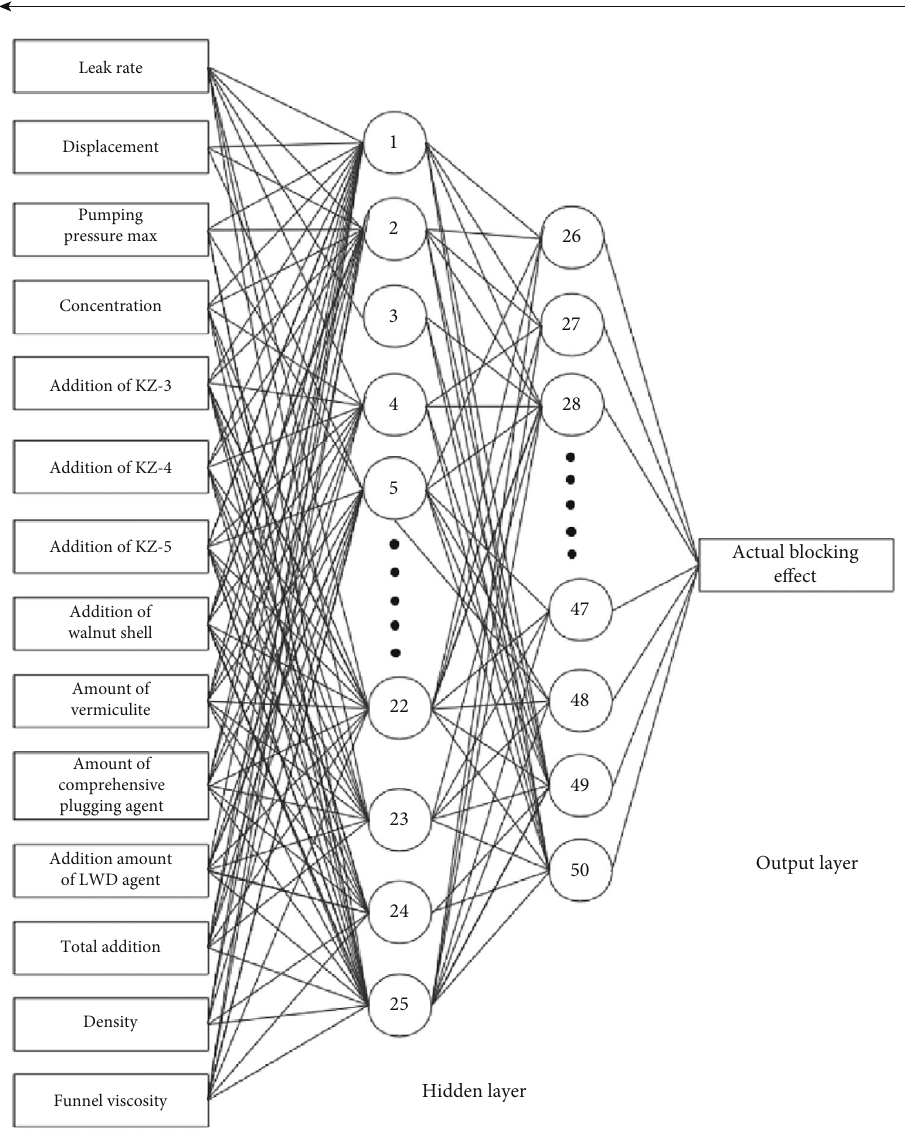
Figure 12: Topological structure of the ANN model